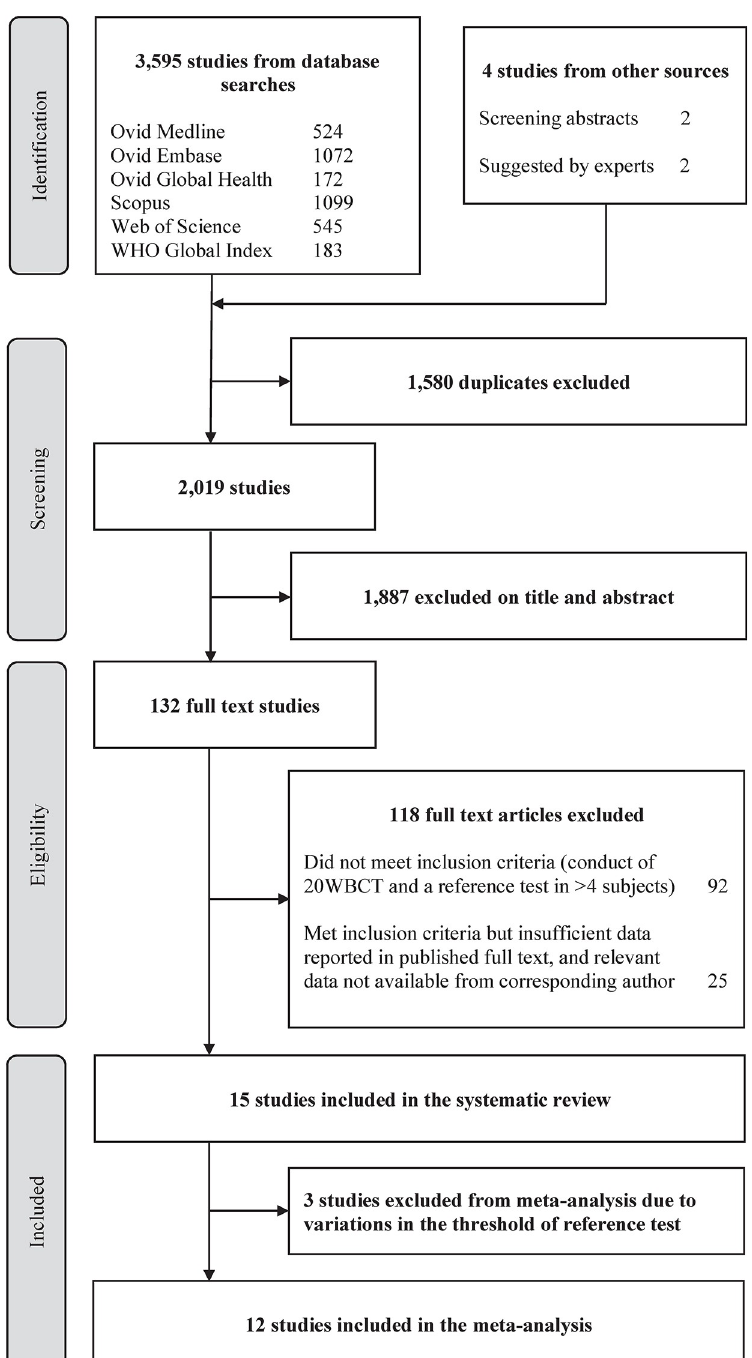
Fig 1. PRISMA-DTA flow chart. The data from the 15 studies, with 2,270 patients, included in the systematic review are summarized in Table 1. These studies report data from Thailand (n = 4), India (3), Sri Lanka (3), Brazil (2), Nepal (2) and Papua New Guinea (1), on a variety of different snake genera: Daboia (n = 7), Trimeresurus (5), Hypnale (3), Echis (2), Bothrops (2), Calloselasma (1), Ovophis (1), Bungarus (1) and Oxyuranus (1). In several studies, snake genus and species was unknown.